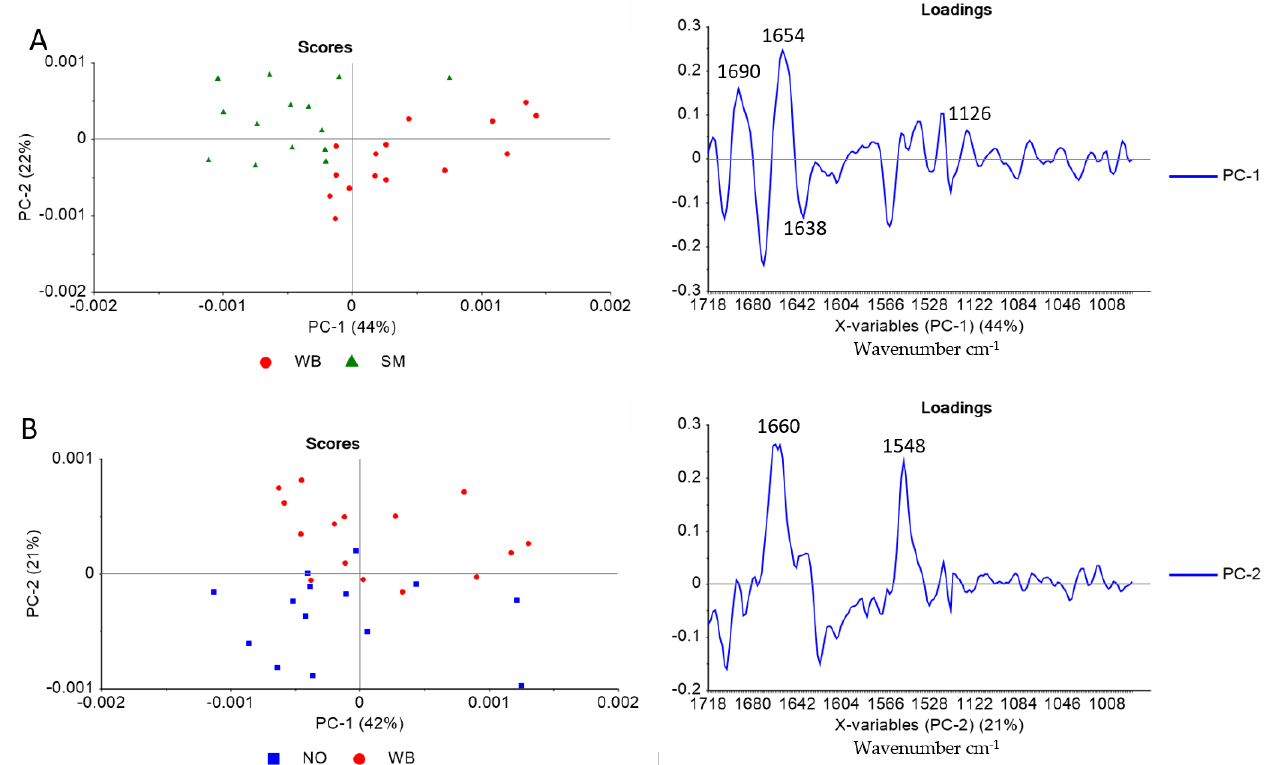
Figure 4. PCA Score and loading plot for the amide I & II region (1718–1492 cm − 1 ) and the carbohydrate region (1140–985 cm − 1 ) for ( A ) WB and SM samples; and ( B ) NO and WB samples.